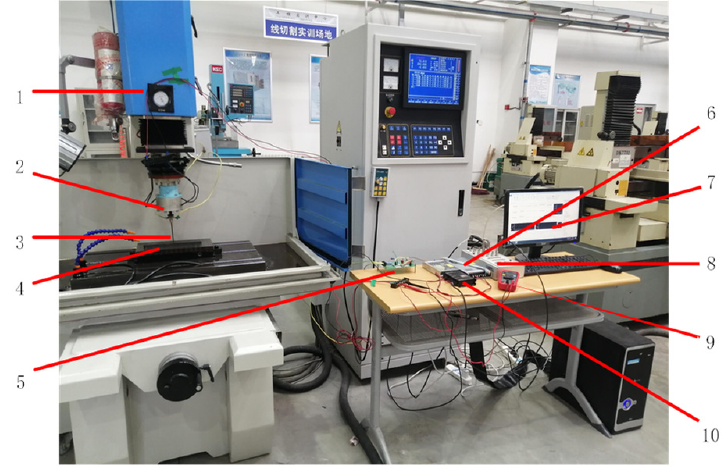
Figure 11. Experimental system of micro-EDM. 1: Micro electrical discharge machining. 2: Magnetic actuator. 3: Tool electrode. 4: Machining workpiece. 5: Discharge gap voltage detection circuit. 6: Switching DC power supply. 7: Computer. 8: dSPACE1104. 9: Multimeter. 10: Current power amplifier. Table 6 shows the parameter settings of the micro-EDM machine tool. Table 6. Parameters of micro-EDM machine